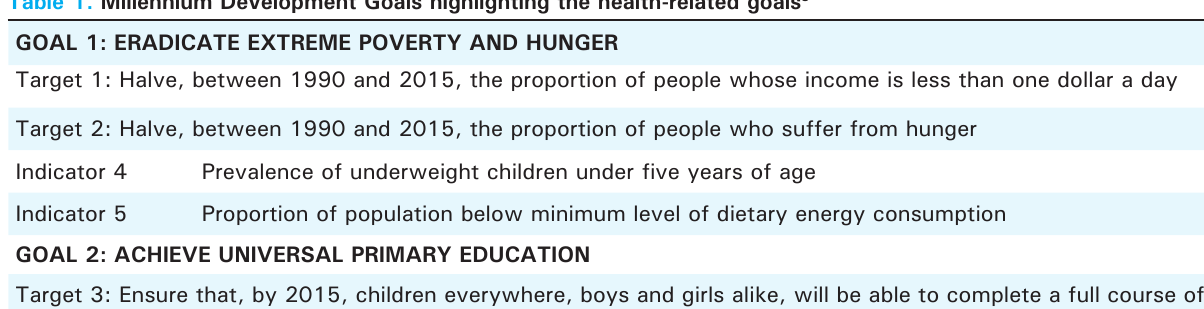
table 1. Millennium Development Goals highlighting the health-related goals 3 GOAL 1: eRADIcAte eXtReMe POVeRtY AnD